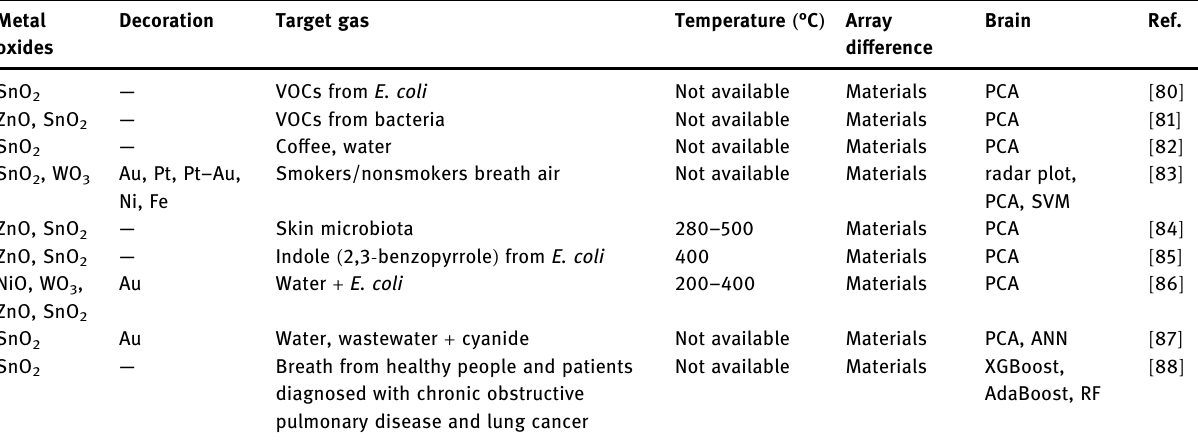
Table 3: List of scienti fi c papers on electronic noses based on metal oxide nanowires applied to the health fi eld Metal